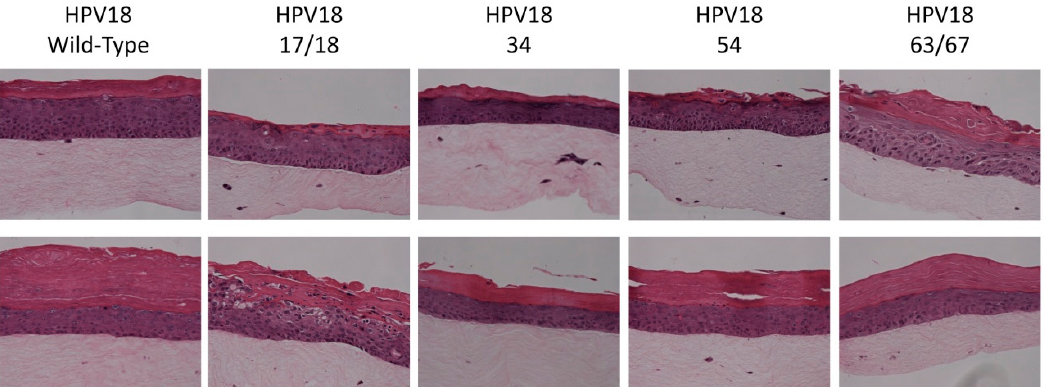
Figure 2. Mutations in the HPV18 E1^E4 protein do not affect organotypic raft growth. HPV18 WT and HPV18 mutant E1^E4 organotypic raft cultures grown for 10 (top row) and 20 (bottom row) days. Tissue sections were cut and stained with hematoxylin and eosin (H&E). Images are 10× magnification. Tissue sections are representative of rafts grown from at least two different cell lines produced for each virus type.